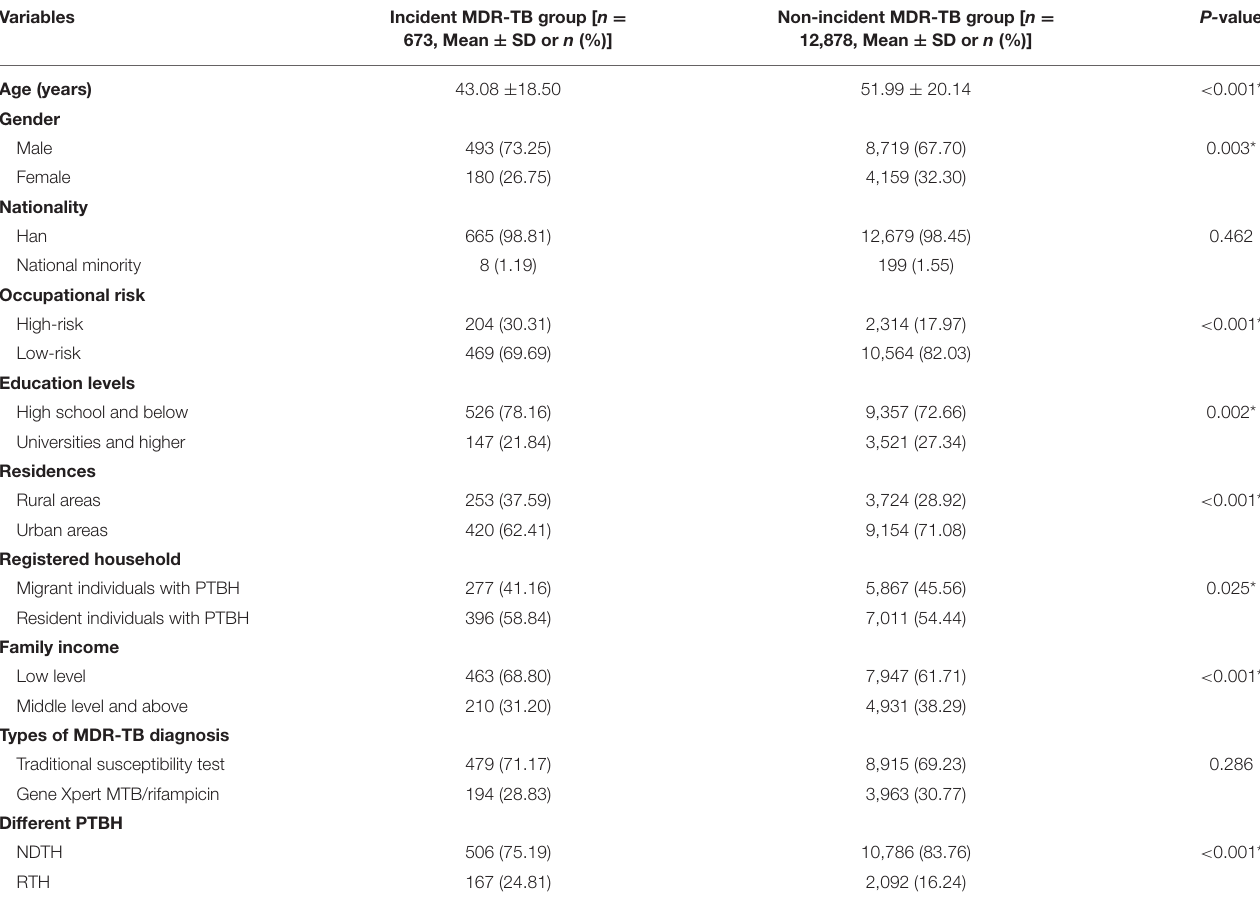
TABLE 2 | Basic characteristics of the study population ( N =